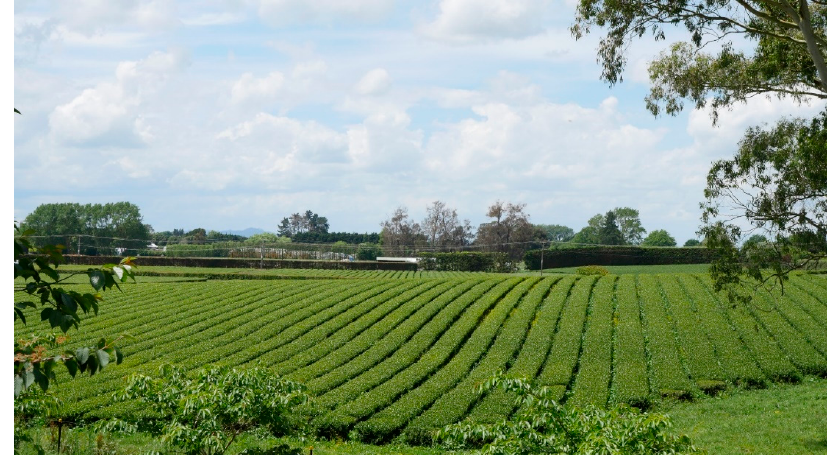
Figure 4. Tea ( Camellia sinensis ) growing well on Kainui soils (Kandiudults) at the Zealong Tea Estate almost directly across the road from the Gordonton Road section (Figures 1 and 3). Some of the Kainui soil’s physical properties and some climatic conditions, however, are towards the limits for commercial tea, which typically requires light (coarser-textured), friable soils and good drainage. The silt-rich coverbed, its moderate drainage, and its marginal thermic soil temperature regime, seem to meet the needs. Although the soil moisture regime is udic, both drought and frost can occur [73] and tea can be susceptible to these conditions. The perching of water on the buried paleosol, giving rise to saturation possibly for several days or near saturated conditions for several months (see text), is evidently able to be tolerated. A favourable feature for tea is the moderately to strongly acid subsoil in the upper Kainui soils [35,51,55]. Photo: S.J.